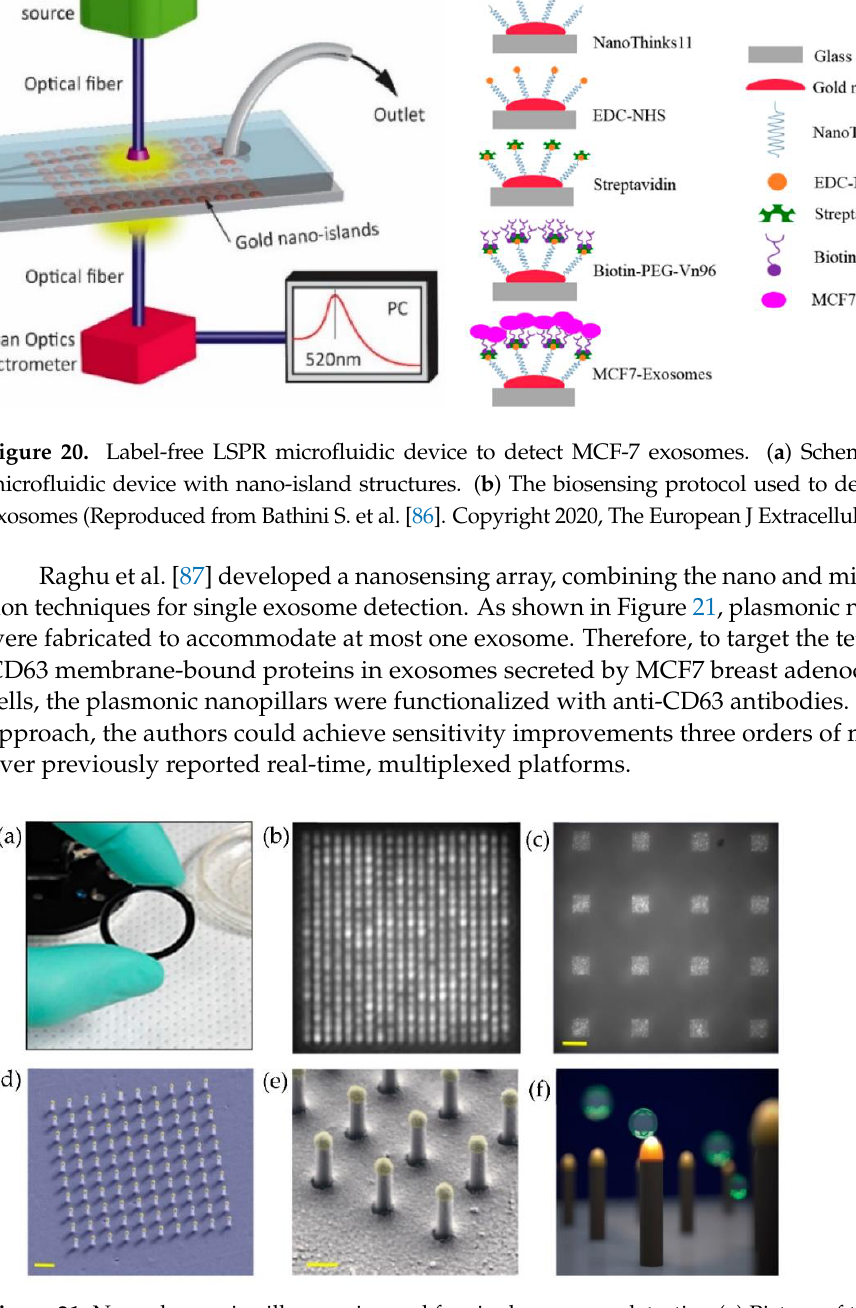
Figure 21. Nanoplasmonic pillars engineered for single exosome detection ( a ) Picture of the 25.4 mm diameter LSPRi sensor chip. ( b ) Scanning electron microscope image of the device for a 20 × 20 array, with a pitch size of 600 nm scale bar: 1 µ m. ( c ) Image of sixteen arrays, each consisting of 400 plas- monic nanopillars in a 20 × 20 square lattice and 500 nm pitch, scale bar: 10 µ m. ( d ) False coloured SEM image of a 10 × 10 nanopillar array, scale bar: 1 µ m. ( e ) High-magnification false-coloured SEM image showing a detailed view of individual nanopillars, scale bar: 200 nm. ( f ) Picture il- lustrating the size matching of individual nanopillars diameter (d = 90 nm) to that of exosomes (~50 nm < d < 200 nm). (Reproduced from Raghu D. et al. [87]. Copyright 2018, PLoS